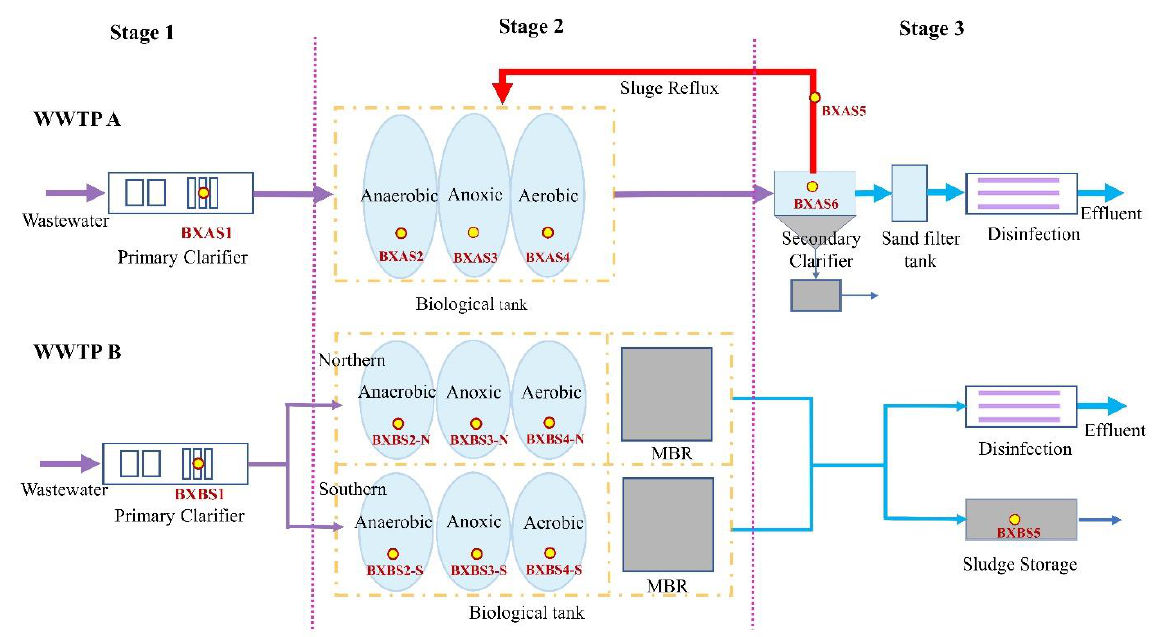
Figure 1. Schematic drawing of the two projects. Sampling points are indicated by yellow dots.